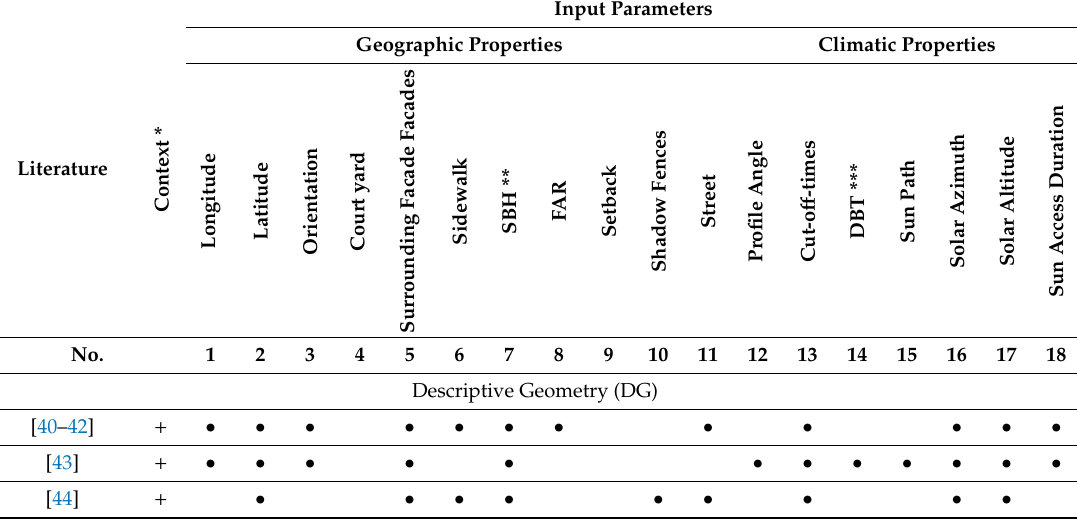
Table 1. Database of design parameters and computational method of solar envelopes based on the selected